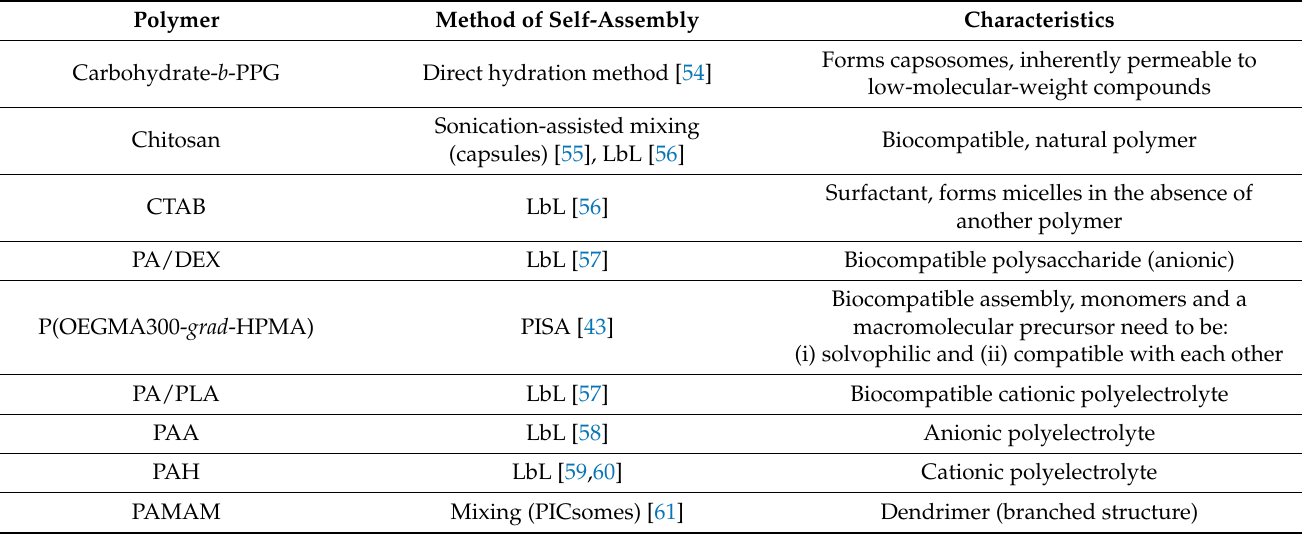
Table 1. Polymers used for biomedical